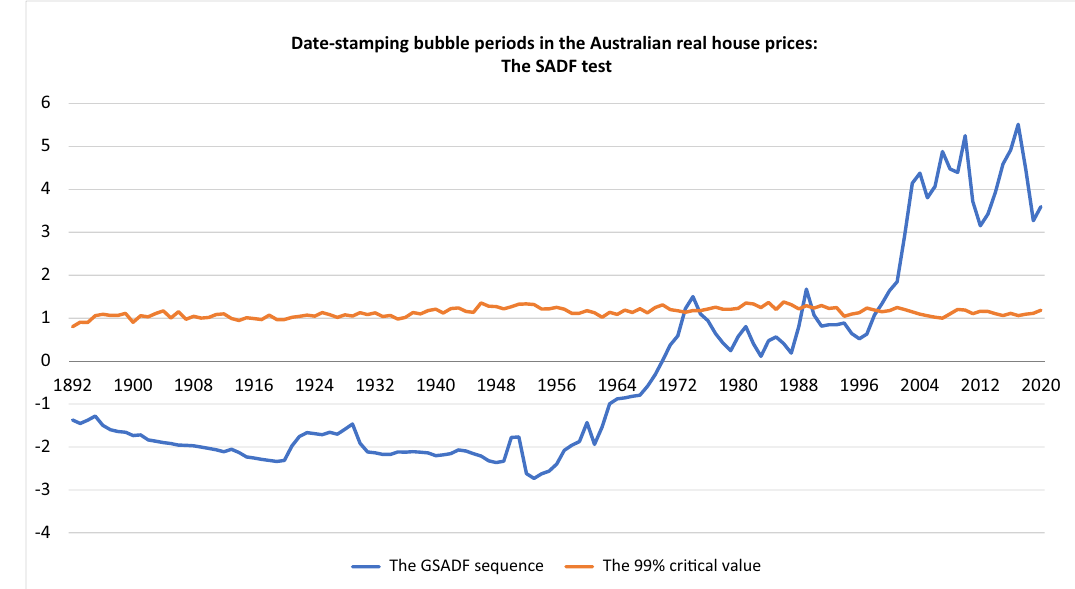
Figure 4: Date - stamping bubble periods in the Australian real house prices: The SADF test.